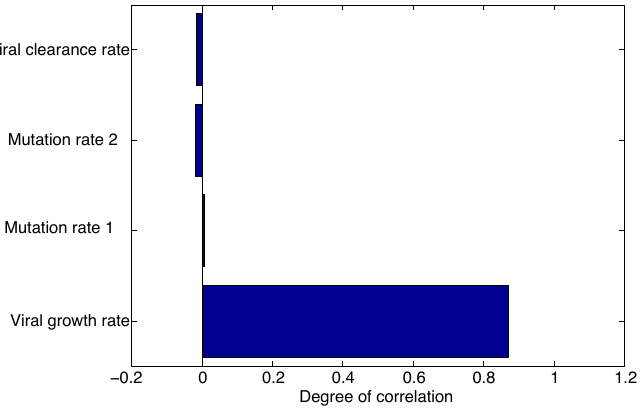
Figure 7. Tornado plot showing partial rank correlation coefficients (PRCCs) of R dependent parameters. The parameter with the largest impact on R rate, r . W